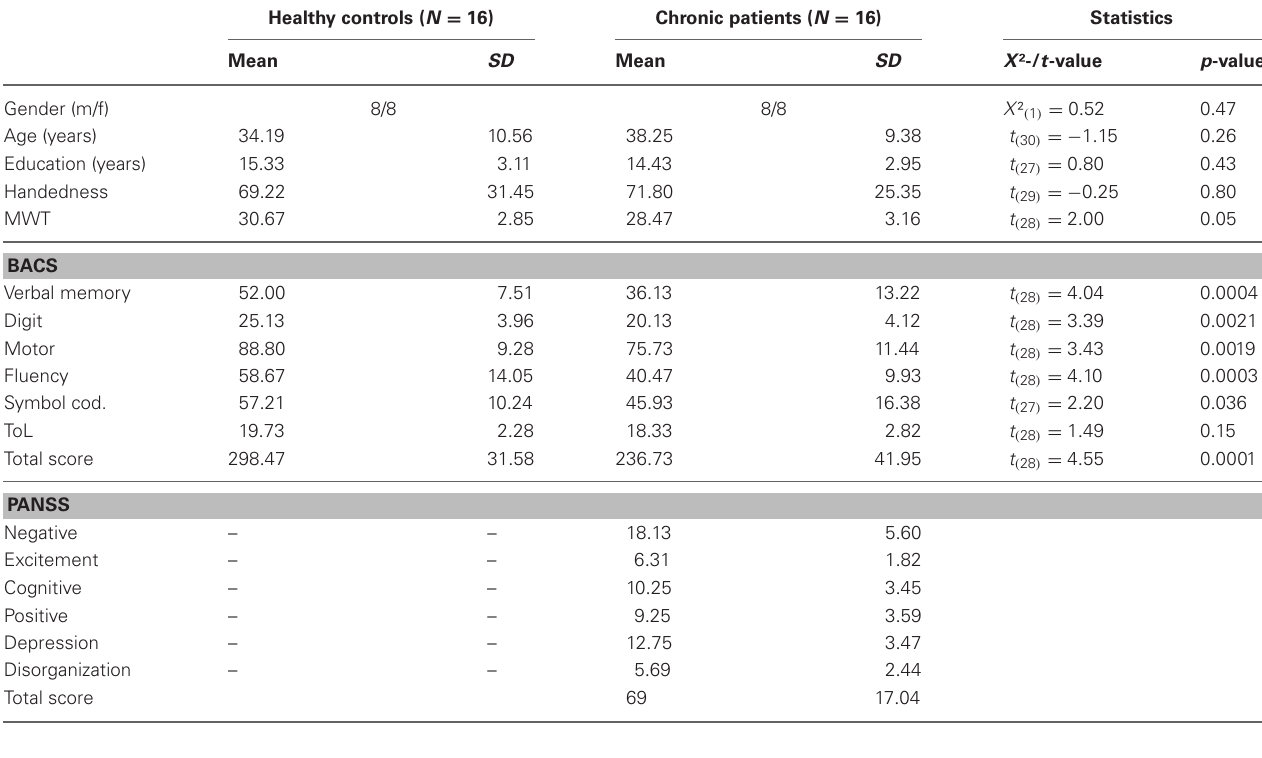
the center of the screen between trials. Prior to data collection, participants performed a practice block to become familiar with the task and the response buttons. All participants completed four experimental runs, each of which was composed of 60 upright and 30 inverted-scrambled stimuli. The stimuli were displayed in the center of a translucent screen at a viewing distance of 53 cm and subtended 19 ◦ of visual angle. An LCD projector located outside the magnetically shielded room of the MEG was used to project the stimuli onto the screen via two front-silvered mirrors. Stimulus presentation was con- trolled using the Presentation software package (Neurobehavioral Systems, Inc.).